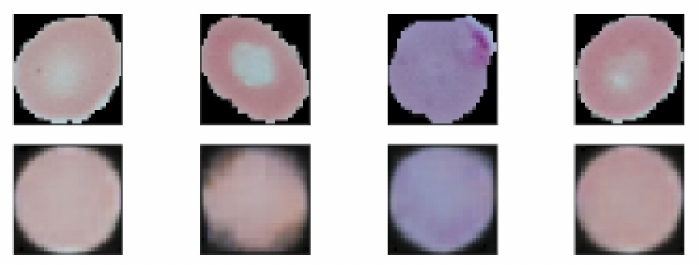
Figure 9. Some reconstructed images after training Autoencoder. Top images are the original image and bottom images are reconstructed images.